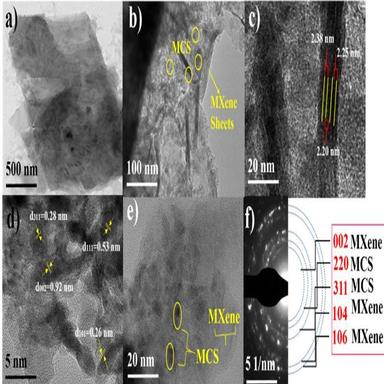
HR-TEM images of (a–e) MCS-MXene (1:2) at different magnifications; (f) SAED pattern of MCS-MXene (1:2).